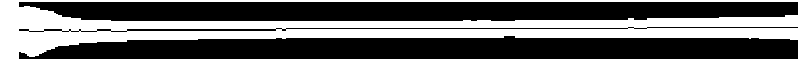
Figure 12. The original image of the light stripe, and the center graph of the light stripe extracted by each algorithm. ( a ) The original image of the light stripe; ( b ) Steger; ( c ) the gray-scale center of gravity; ( d ) geometric center; and ( e ) the improved gray-scale center of gravity.